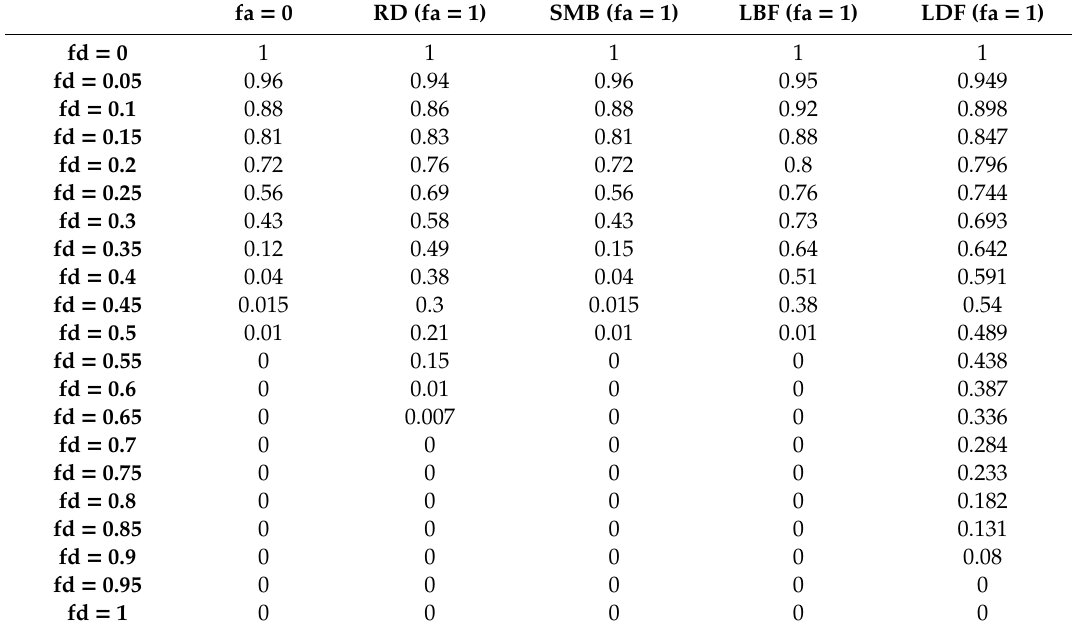
Table 6. Simulation data of di ff erent edge-increasing